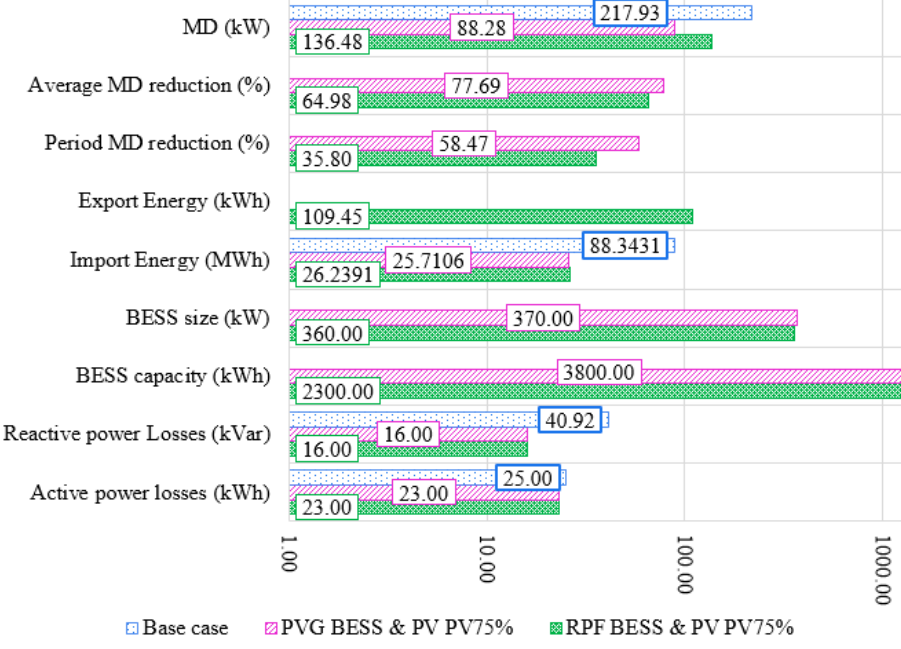
Figure A4. Comparison of PVGS and RPFS with 100% PV penetration level (January 2016). References 1.